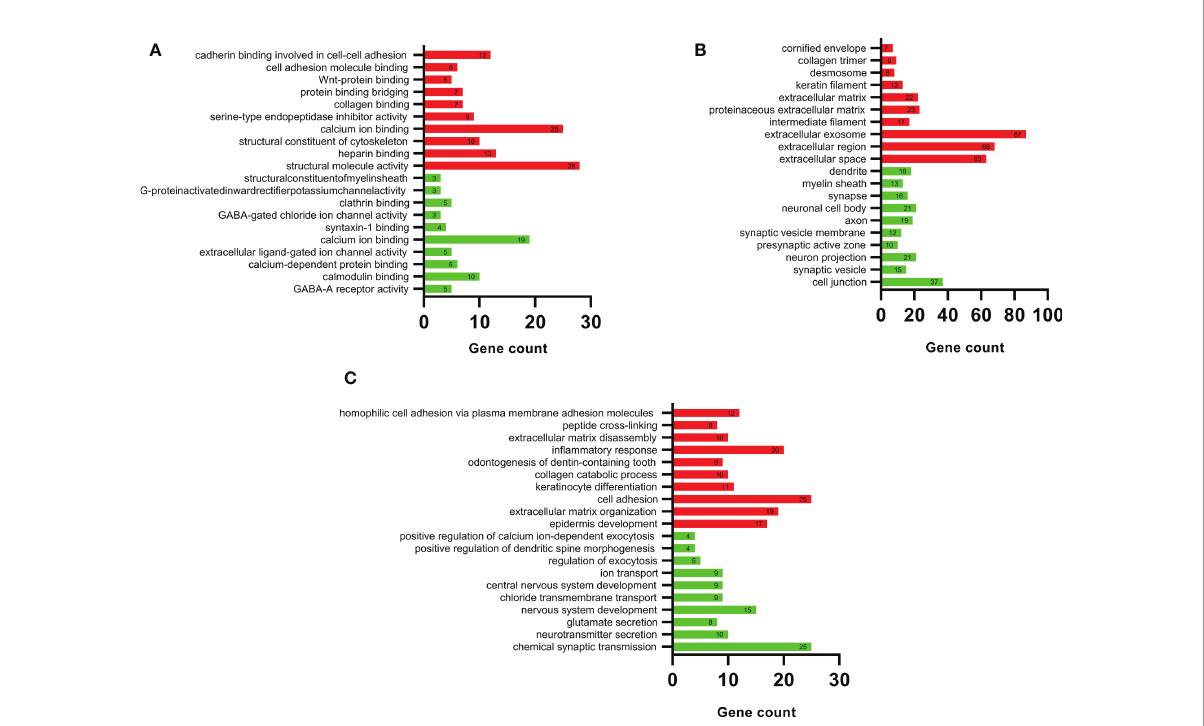
FIGURE 3 DAVID GO enrichment analysis results. According to the three functions of (A) molecular function, (B) cellular component, and (C) biological process, the top 10 upregulated (red) and top 10 downregulated (green) terms in each category.